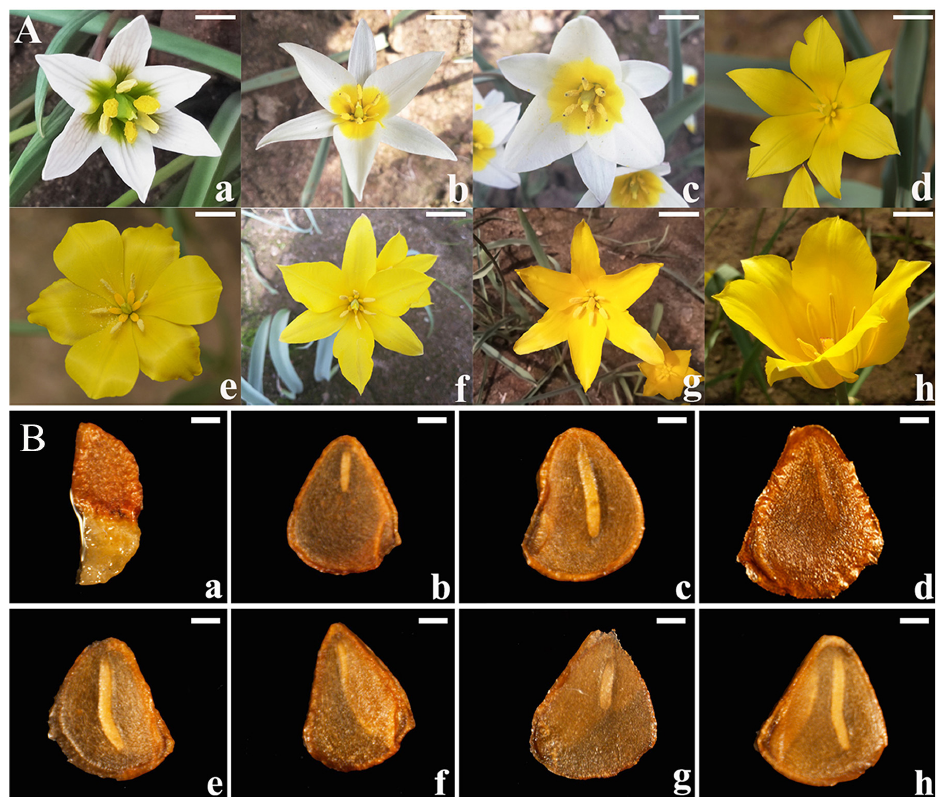
Figure 1. The flowers and seeds of eight wild Tulipa species native to China. Bar = 1 cm ( A ). flowers ( B ). seeds; ( a ) to ( h ) in turn represent respectively T. edulis , T. patens , T. buhseana , T. altaica , T. thianschanica , T. sinkiangensis , T. iliensis , and T. schrenkii . Table 3. The seed characters of the eight wild Tulipa species native to China.